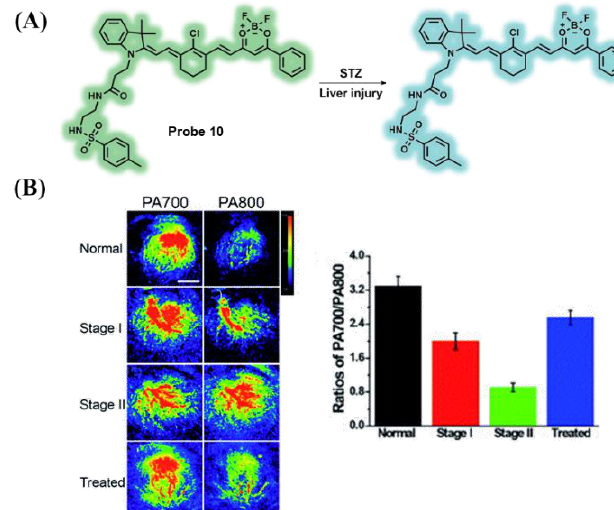
Figure 8. ( A ) Imaging mechanism of probe 10 ; ( B ) photoacoustic images at PA700 and PA800 of probe 10 (100 μM) in the liver tissue of mice. Scale bar: 5.0 mm. Adapted from Reference [71]. Copyright 2017, the Royal Society of Chemistry.